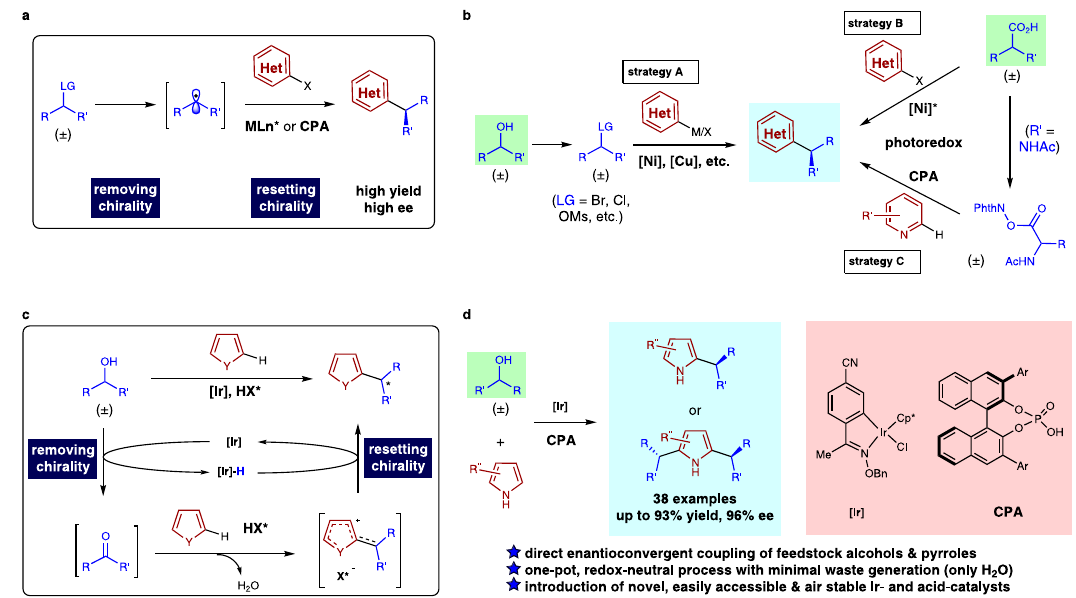
Fig. 1 Redox- vs. radical-based enantioconvergent (hetero)arylation. a General mechanism of radical-based enantioconvergent (hetero)arylation. b Different strategies achieved for enantioconvergent (hetero)arylation using the radical mechanism. c The working hypothesis of redox-enabled enantioconvergent heteroarylation of feedstock secondary alcohols. d This work: enantioconvergent reaction of feedstock secondary alcohols with pyrroles catalyzed by oxime-derived iridacycle and chiral phosphoric acid ( CPA )